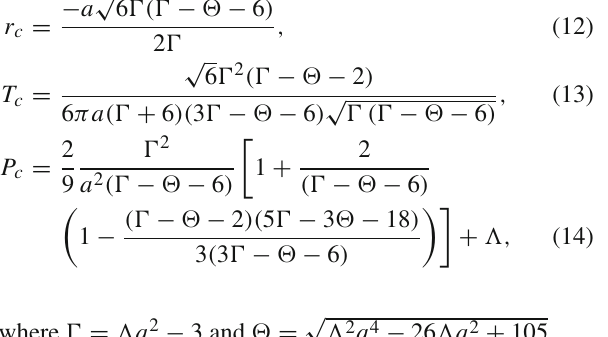
Table 2 Panel (a): critical values for (cid:2) = − 0 . 1 with different